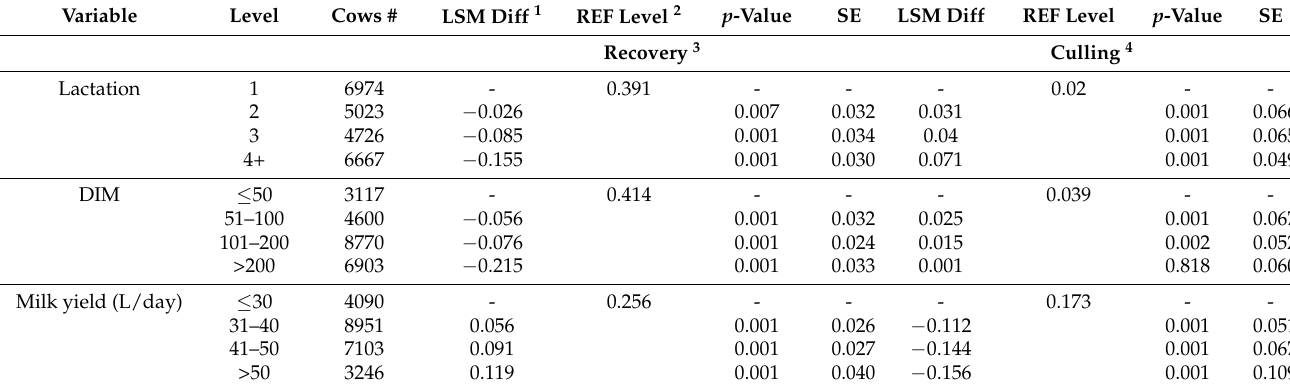
Table 3. Association between lactation number, days in milk (DIM) and milk yield on day of somatic cell count (SCC) elevation to between 300 × 10 3 and 399 × 10 3 cells/mL (CL2) with spontaneous recovery (<250 × 10 3 cells/mL) (R2) and culling percentage (90 days) from mastitis event.